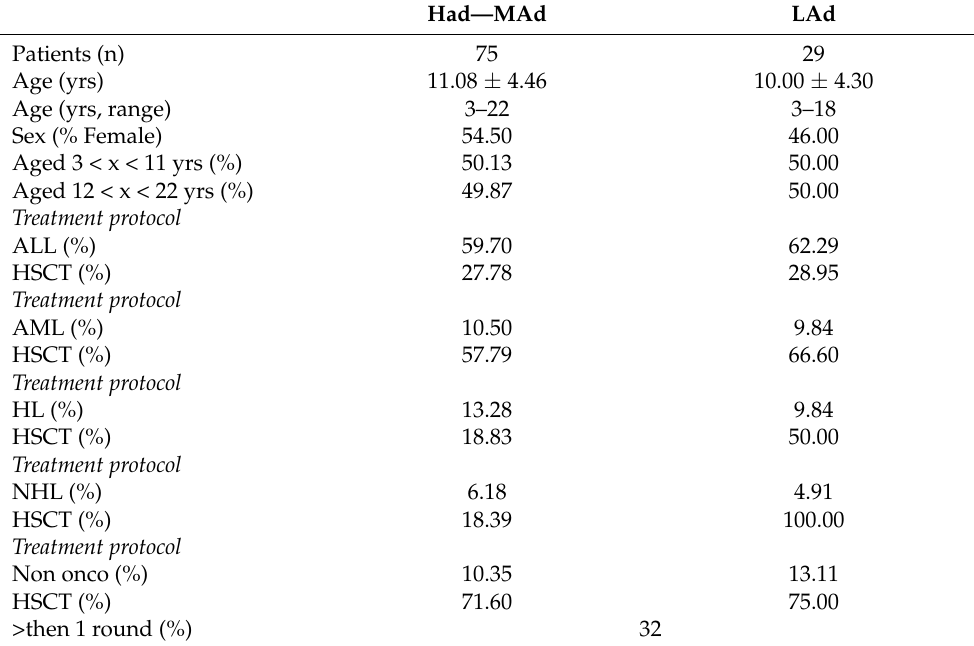
Table 1. Clinical characteristics of CAYA-H divided into high, medium, or low adherence groups (HAd, MAd, LAd, respectively). ALL: acute lymphoblastic leukemia; AML: acute myeloid leukemia; HL: Hodgkin lymphoma; NHL: nonHodgkin HSCT: hematopoietic stem cell